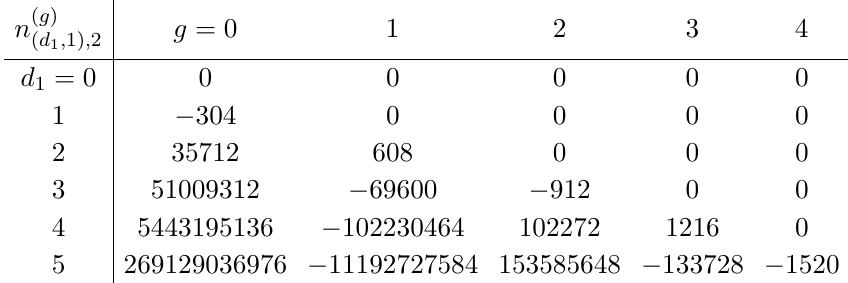
with Z charge 2 . 4 0